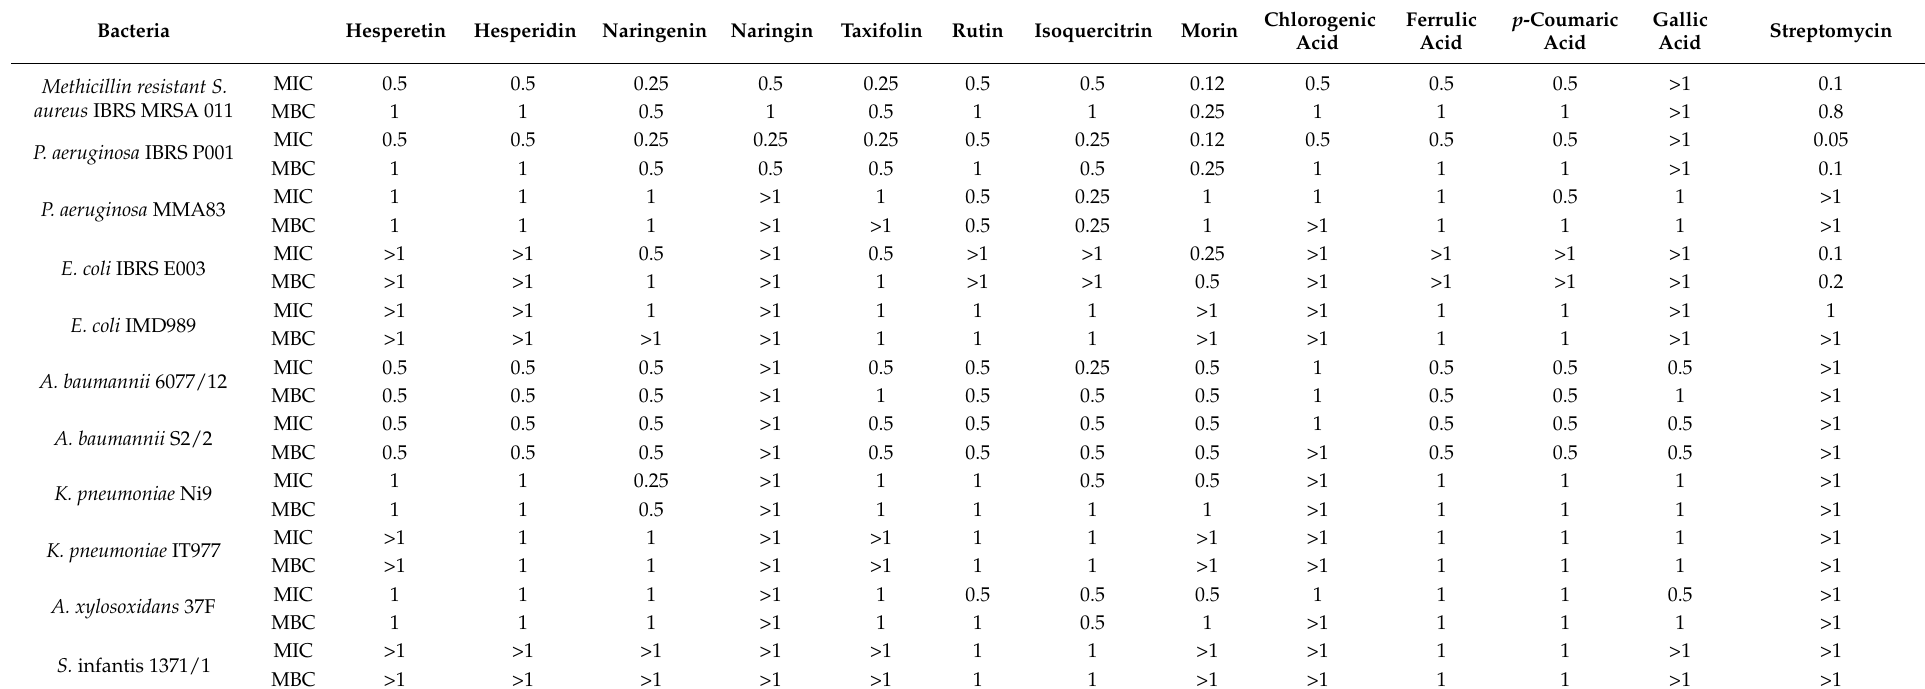
Table 1. Antibacterial potential of selected polyphenols; results are expressed in